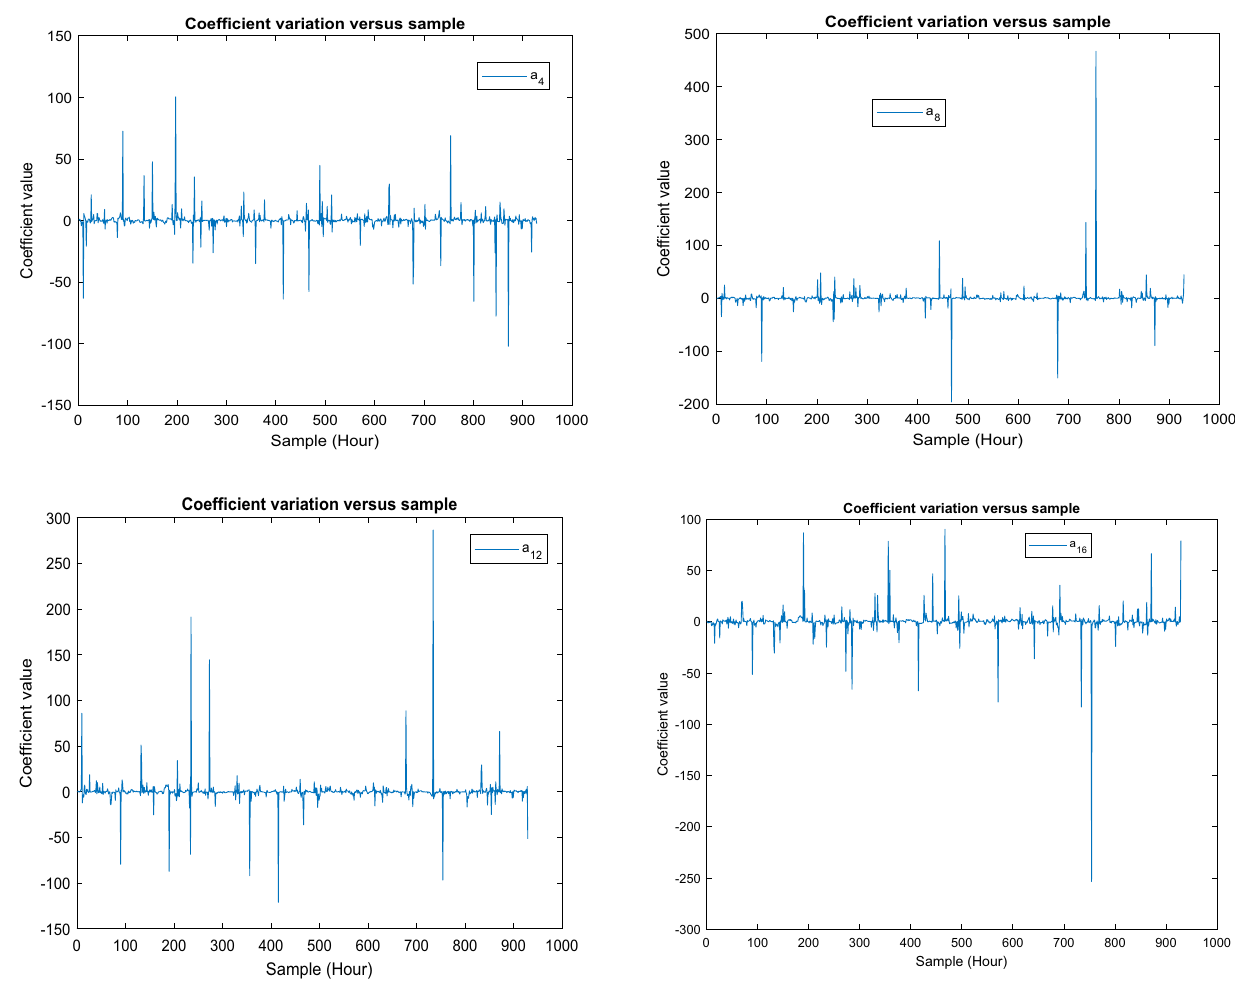
Fig. 6 Hourly variation of the 4th, 8th, 12th, and 16th coefficient for the EUR/USD exchange-rate signal